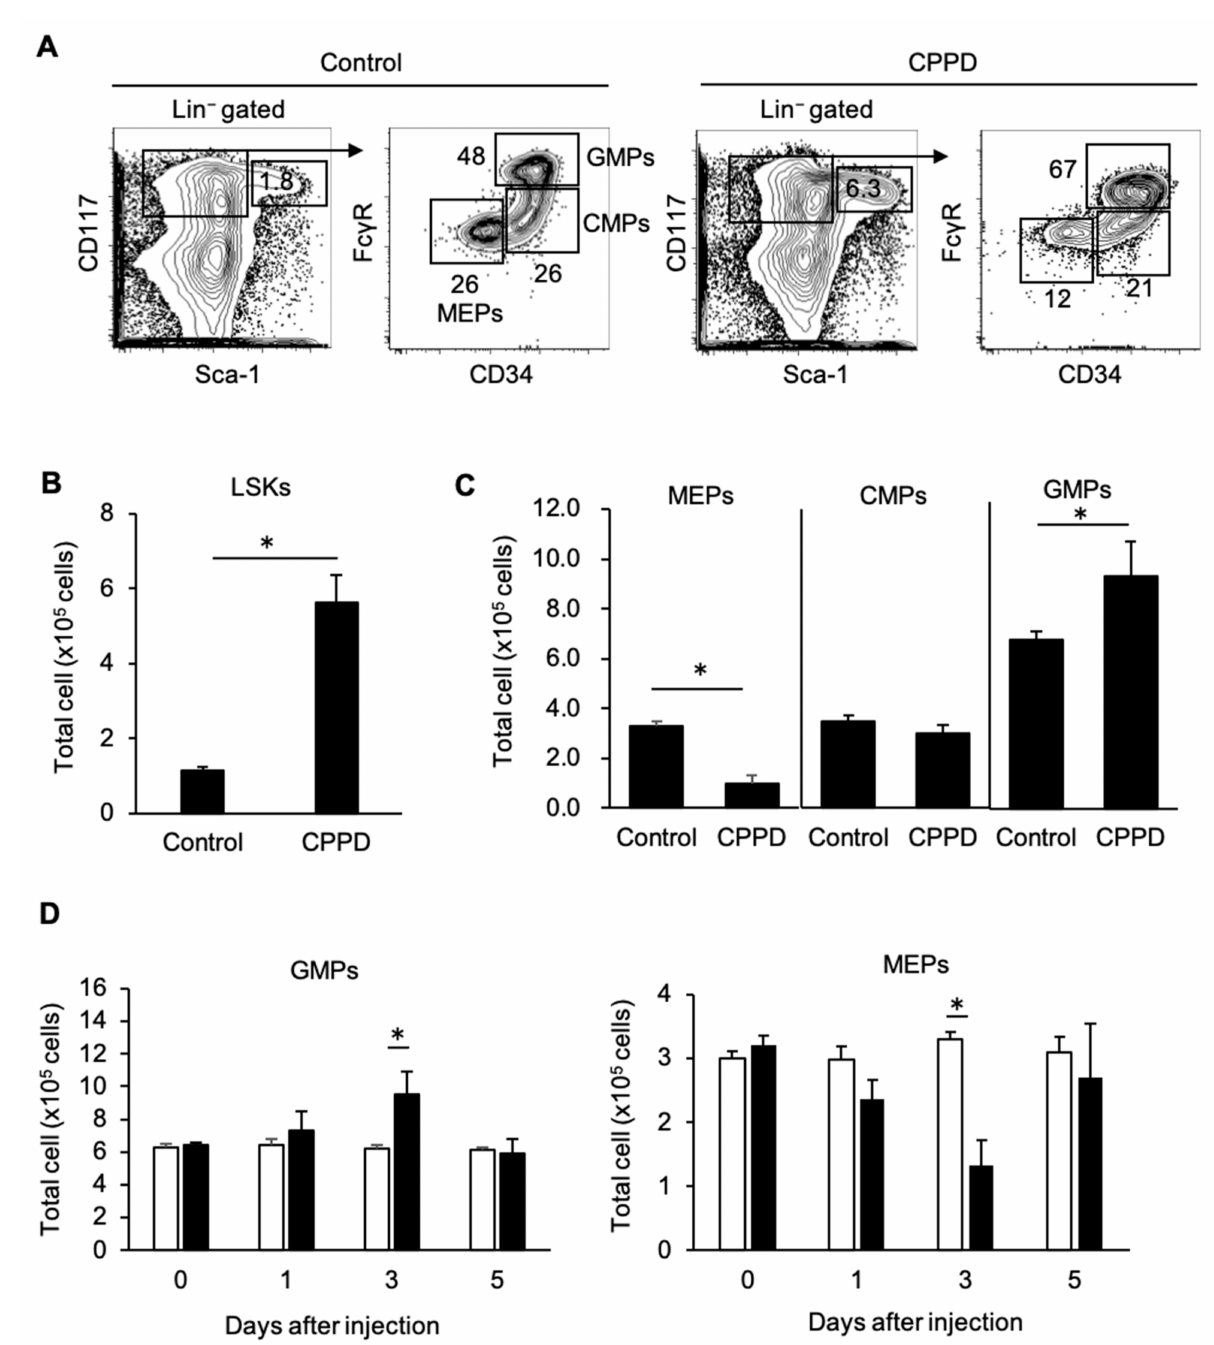
Figure 3. CPPD injection induces granulocytes/monocyte progenitors (GMPs) expansion and megakaryocyte/erythrocyte progenitors (MEPs) reduction in vivo. ( A – D ) The percentage ( A ) and total cell number of lineage − Sca-1 + c-kit + (LSK) cells ( B ) and megakaryocyte/erythrocyte progenitors (MEPs), common myeloid progenitors (CMPs), and granulocytes/monocyte progenitors (GMPs) in the bone marrow 3 days after vehicle (PBS) or CPPD (100 µ g) injection ( C ). ( D ) Time course of absolute cell number of GMP and MEP in the bone marrow after CPPD administration. Data represent the mean ± s.d. of three independent experiments. * p <